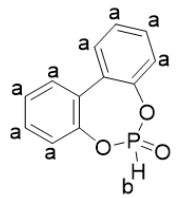
Figure 16. BPPO structure. Figure 16. BPPO